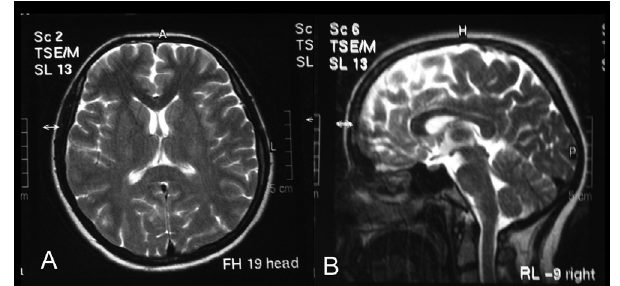
Figure 3 - Transverse (a) and sagittal (b) T2-weighted image showing normal cranial MR findings